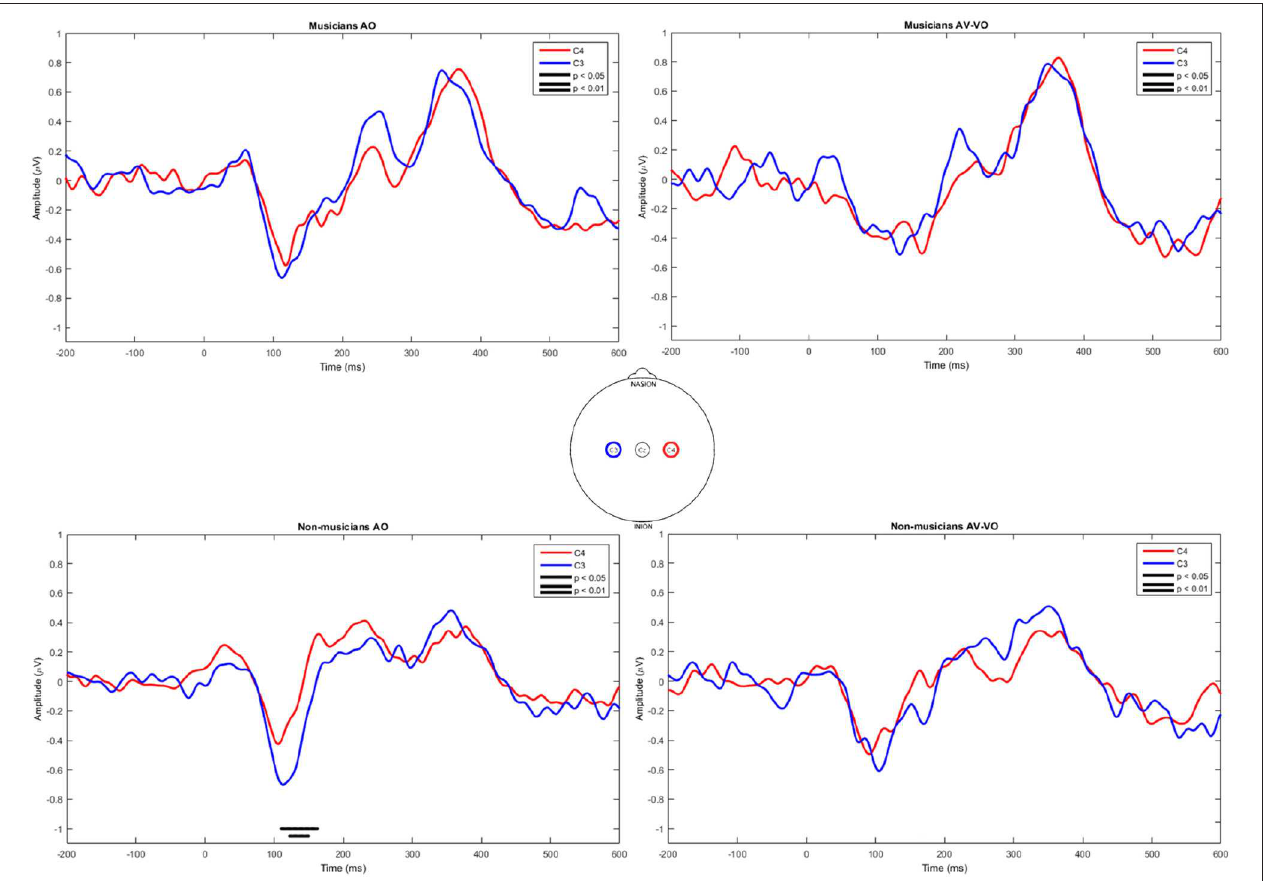
FIGURE 4 | Point-by-point two-tailed t -test for event-related potentials in AO and AV − VO at C3 and C4 for musicians and non-musicians.